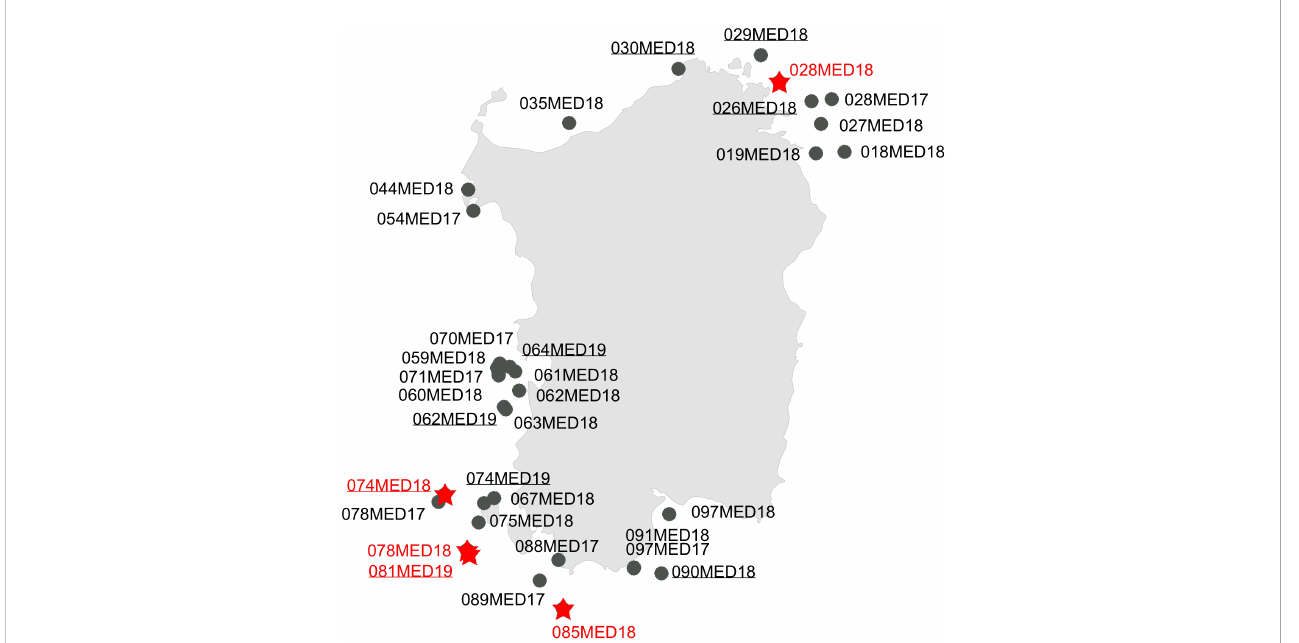
FIGURE 1 Map of the site collection during the MEDITS trawling campaign carried out along the Sardinian coasts. Circles in black = morphotype A ( Spatangus purpureus ); same red = morphotype B ( Propespatagus sp.